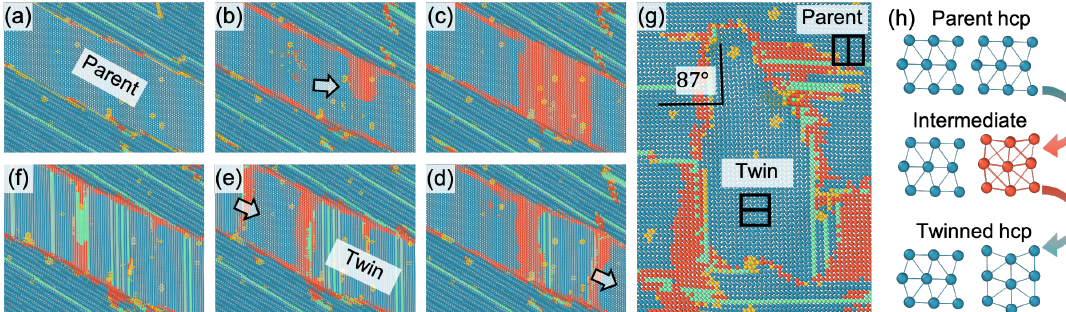
Figure 1. Our MD simulation showing the formation of { 10¯12 } extension twins through ( a , b ) hcp-to-tetragonal and ( c , d ) tetragonal-to-hcp martensitic phase transformations in Mg. The two formed { 10¯12 } twin boundaries ( e ) migrate quickly and ( f ) react with each other and result in a few layers of fcc phase. ( g ) A close-up view shows the { 10¯12 } twin orientation of the newly formed hcp phase with the parent hcp phase: 87 ◦ misorientation across a common a -axis. ( h ) Schematic illustration of the twin formation process. Hcp, bcc-like (tetragonal), fcc, and amorphous structured atoms are shown by cyan, red, green, and yellow colors, respectively. In ( a – g ) the long lines of green atoms are partial stacking